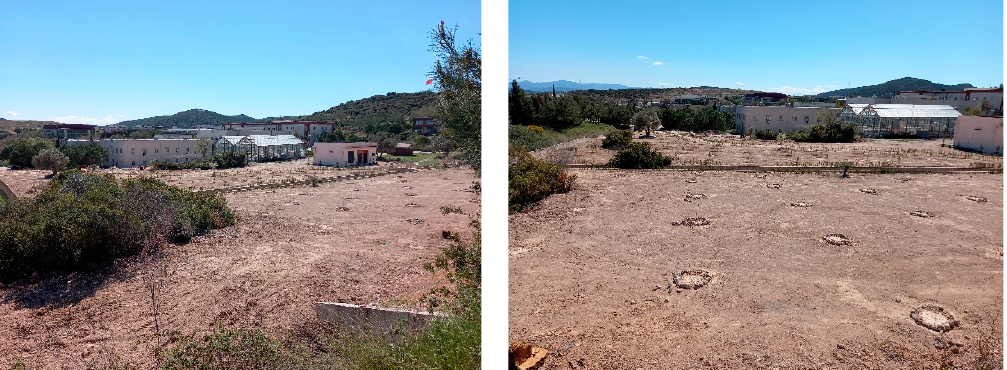
Figure 7. The new soil remediation area and plantation of trees in front of the Faculty of Science.